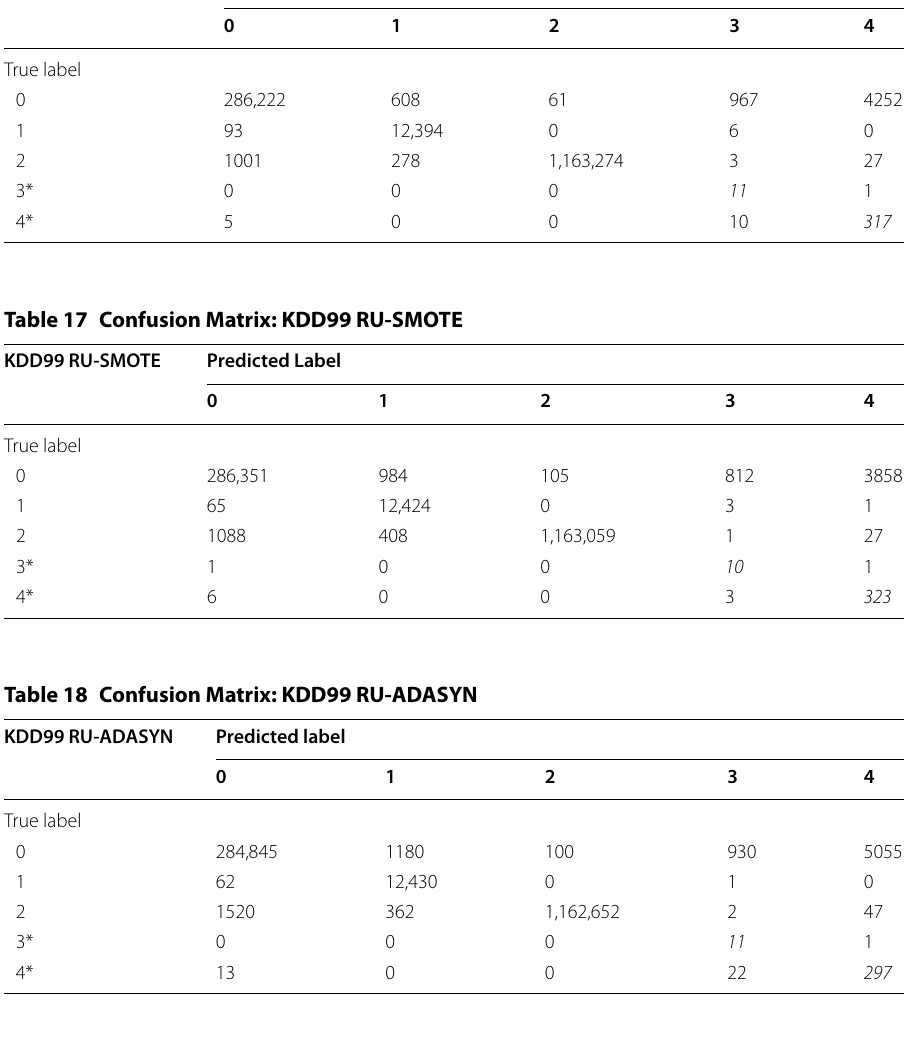
Table 16 Confusion Matrix: KDD99 RURO KDD99 RURO